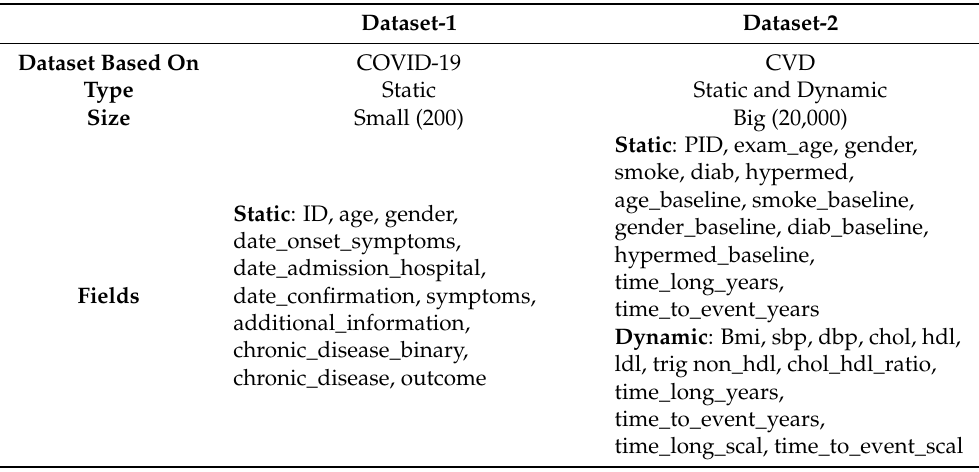
Table 2. Summary of the datasets used in our